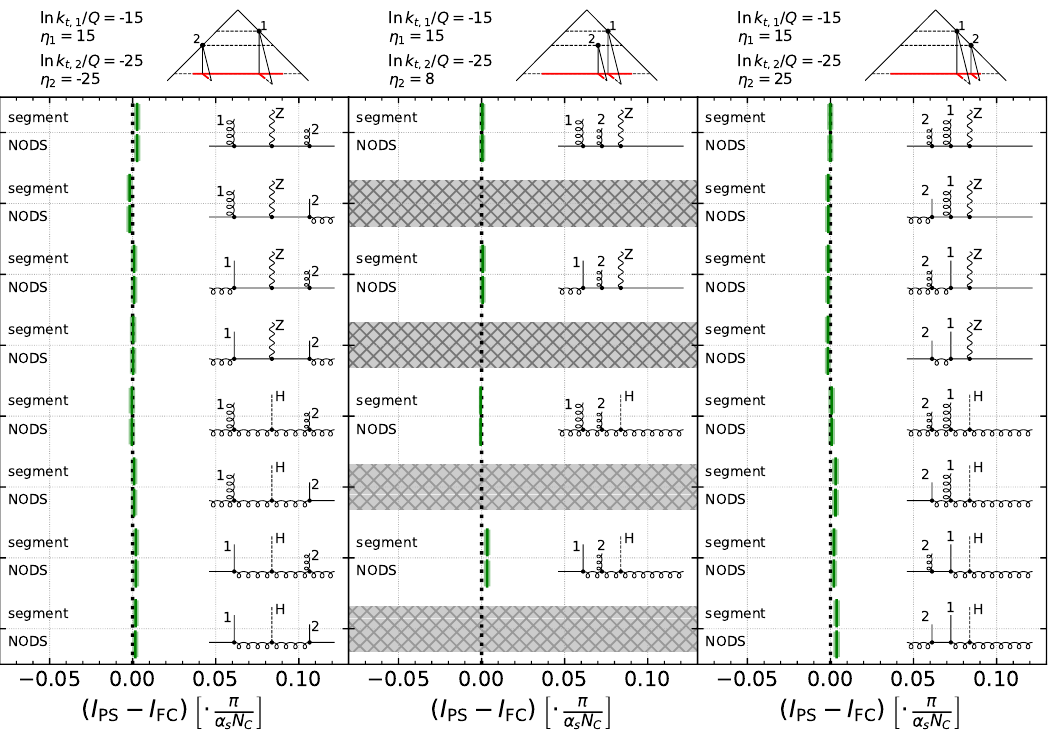
Figure 11. Similar to figure 10, but for soft emission from configurations with two prior initial- state emissions (well separated in rapidity, at least one of which is